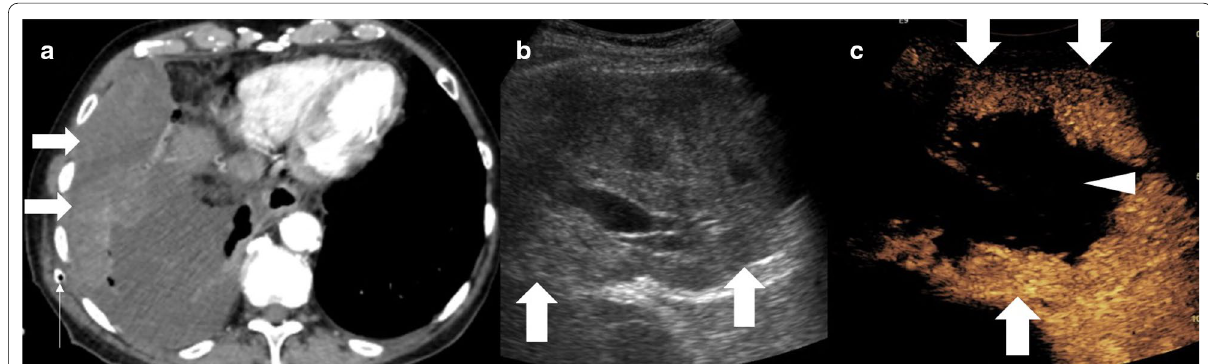
Fig. 3 Male patient with recent chest drainage catheter insertion. a A CT examination showed focal heterogenous density (arrow) within a pleural effusion, thought to be a haematoma secondary to the drainage catheter insertion (thin arrow). b B mode ultrasound of the lesion (arrow) is of a predominantly solid appearance. c CEUS defines the large avascular necrotic central component (arrowhead) and a thick enhancing periphery (arrow), indicating that the biopsy had to be taken from the periphery. Histology revealed sarcomatoid mesothelioma